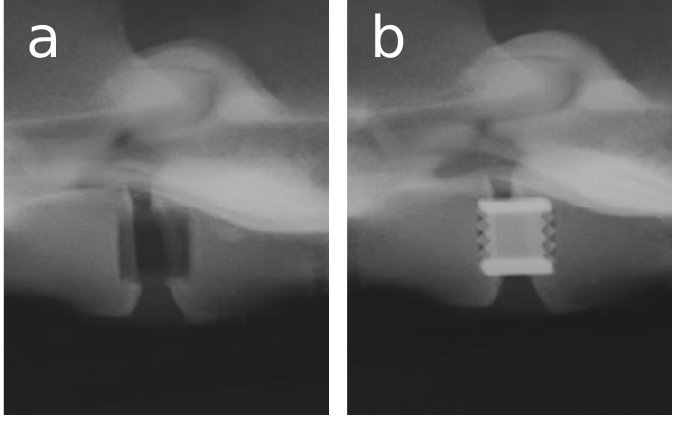
Figure 3. A postoperative lateral roentgenogram of an explanted goat spine with the placement of a radiolucent cage (a) and a titanium cage (b).